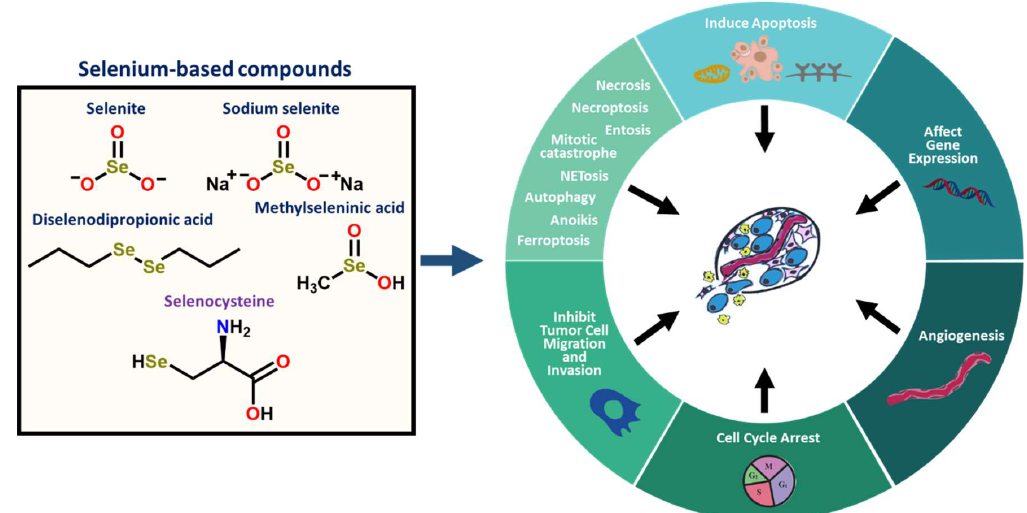
Figure 3. Selenium-based compounds exhibit chemopreventive or chemotherapeutic properties through regulation of various processes such as cell cycle arrest, apoptosis, angiogenesis, etc.